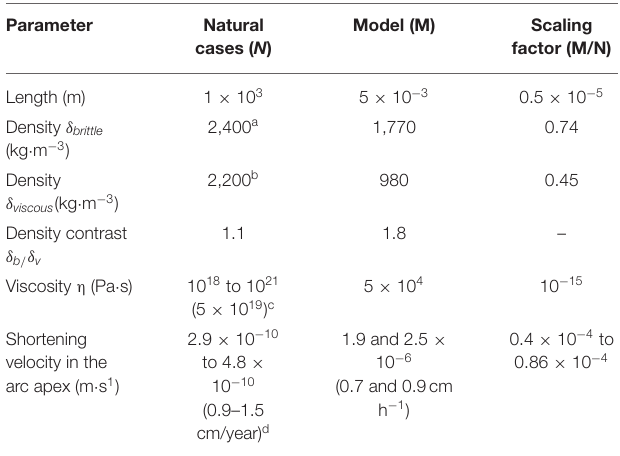
TABLE 1 | Scaling parameters between natural cases and